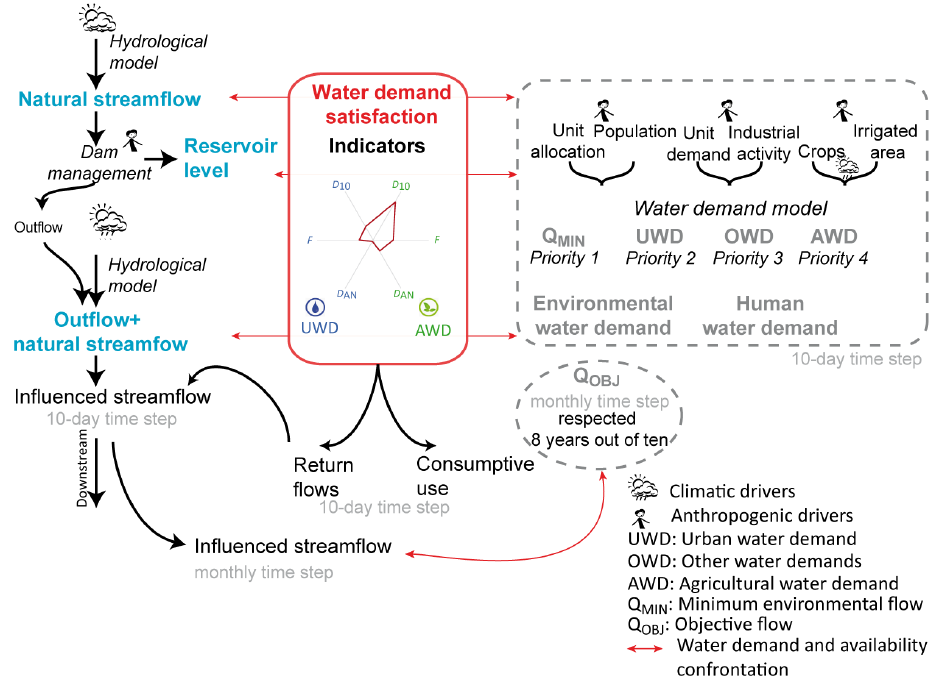
Figure 2. Integrative modeling framework applied at each resource and demand node of the Herault and the Ebro basins. Water demand and natural streamflow were simulated based on climatic and anthropogenic drivers. Anthropogenic influence on streamflow was assessed through the simulation of demand-driven dam management and consumptive use. Water demand satisfaction was assessed by comparing demand to